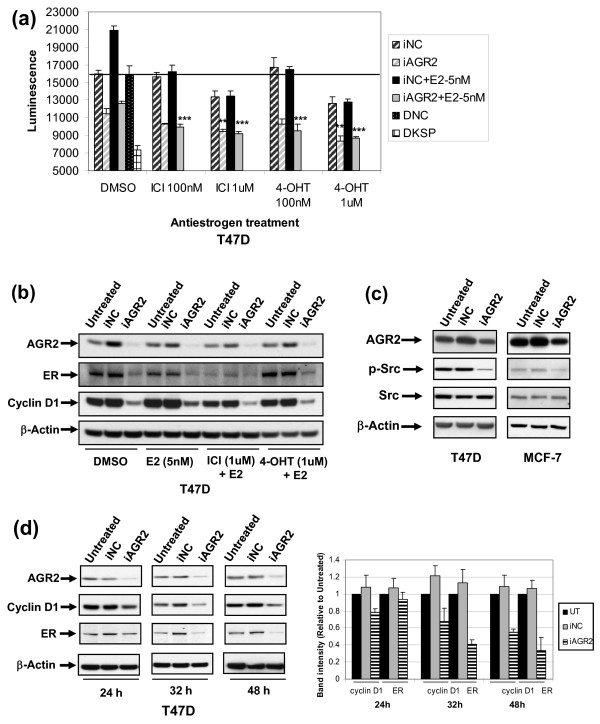
ER-independent activities after AGR2 knockdown. T47 D cells were transfected with iNC or iAGR2, and after 24 hours, cells were treated in combination with 4-hydroxytamoxifen (4-OHT) or ICI 182,780 (ICI) at doses of 100 nM or 1 μM. The growth-inhibitory effects of combination treatments were assessed with Cell Titer Glo 96 hours after transfection (a), or the level of target modulation at 72 hours with Western blot analysis (b). (c) Modulation of p-Src was analyzed 72 hours after AGR2 knockdown. The kinetics of cyclin D1 and ER modulation were determined with Western blot, and densitometric values of cyclin D1 and ER were calculated and normalized to β-actin (Image J) and represented as the mean ± SD, n = 3. *P < 0.05; **P < 0.01; ***P < 0.001, antiestrogen and AGR2 knockdown combination versus AGR2 knockdown alone. Note: Some blots may be from different gels run with the same set of samples.